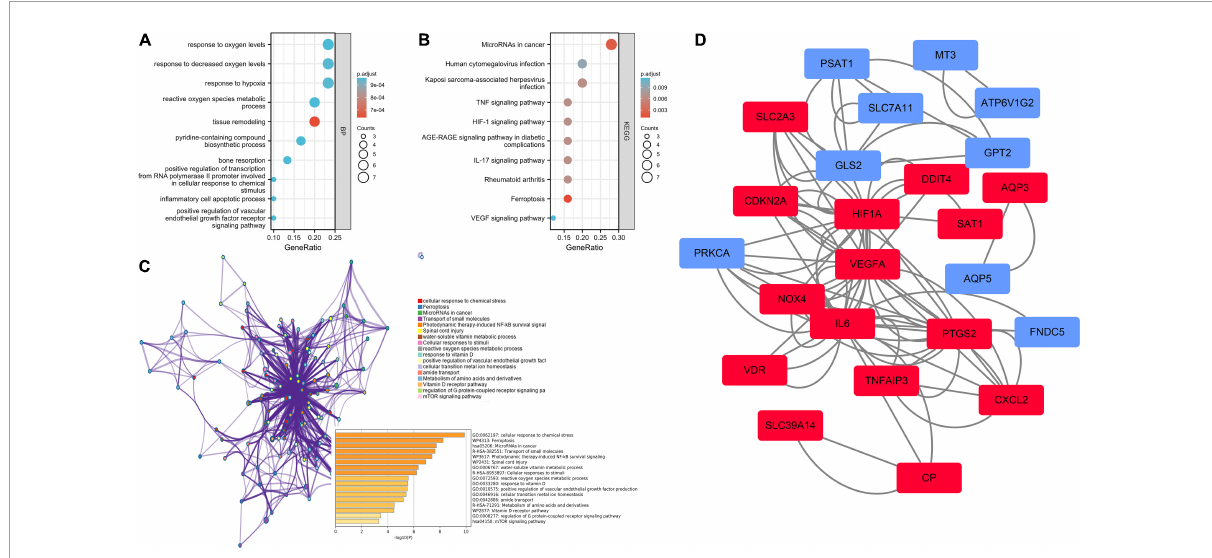
FIGURE3 Enrichment analysis and the protein–protein interaction (PPI) network of the ferroptosis DEGs. (A) Gene set enrichment analysis of Gene Ontology biological process (GO-BP). (B) Gene set enrichment analysis of Kyoto Encyclopedia of Genes and Genomes (KEGG). (C) Network and bar chart of the enrichment results drawn by Metascape. (D) Construction of the PPI network. Navy-blue signifies downregulation and red